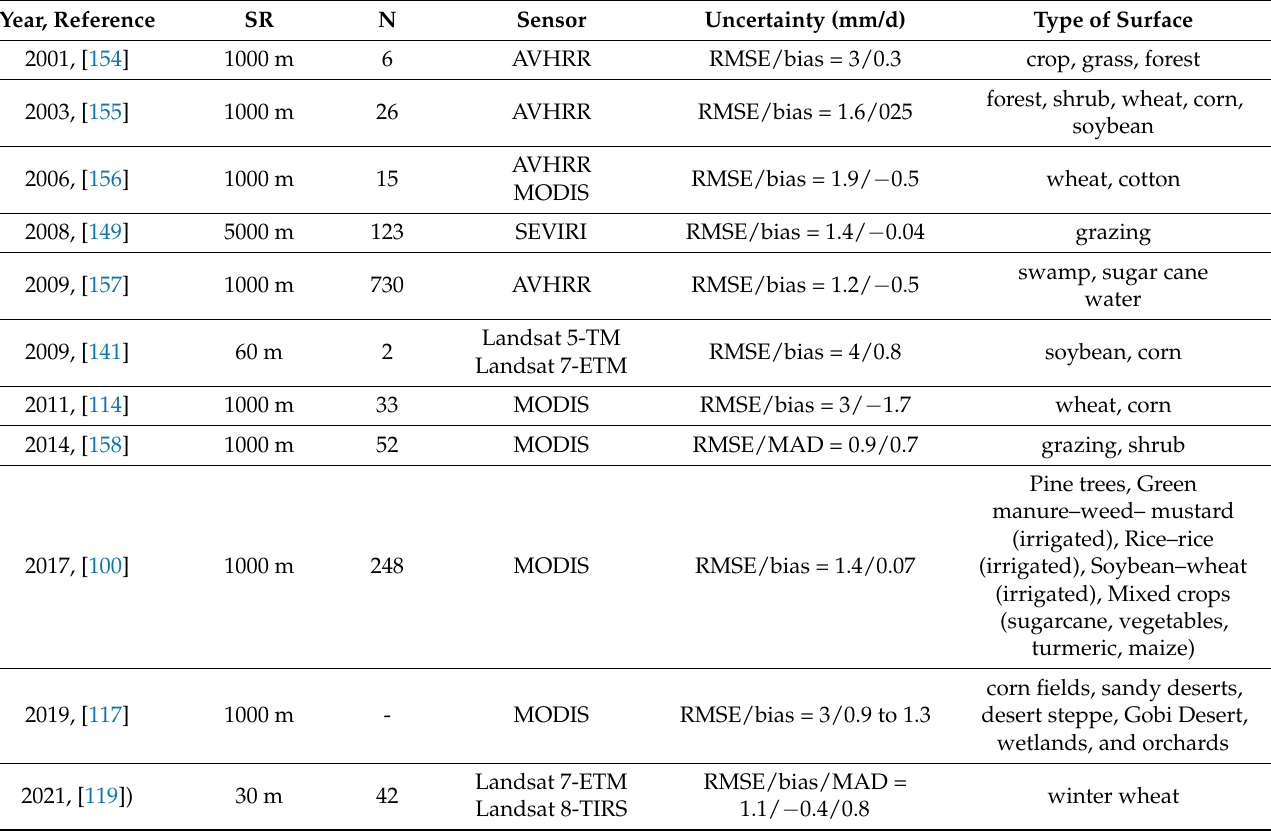
Table 5. Representative chronological compendium of validation studies of the T s − VI Triangu- lar/Trapezoidal methods. Reference, spatial resolution (SR), number (N) of satellite scenes, Sensor Name, Uncertainty and Type of Surface are detailed (uncertainty statistics are averaged values of all type of surface studied). Statistical uncertainties Root Mean Square Error (RMSE) and bias are shown for ET d